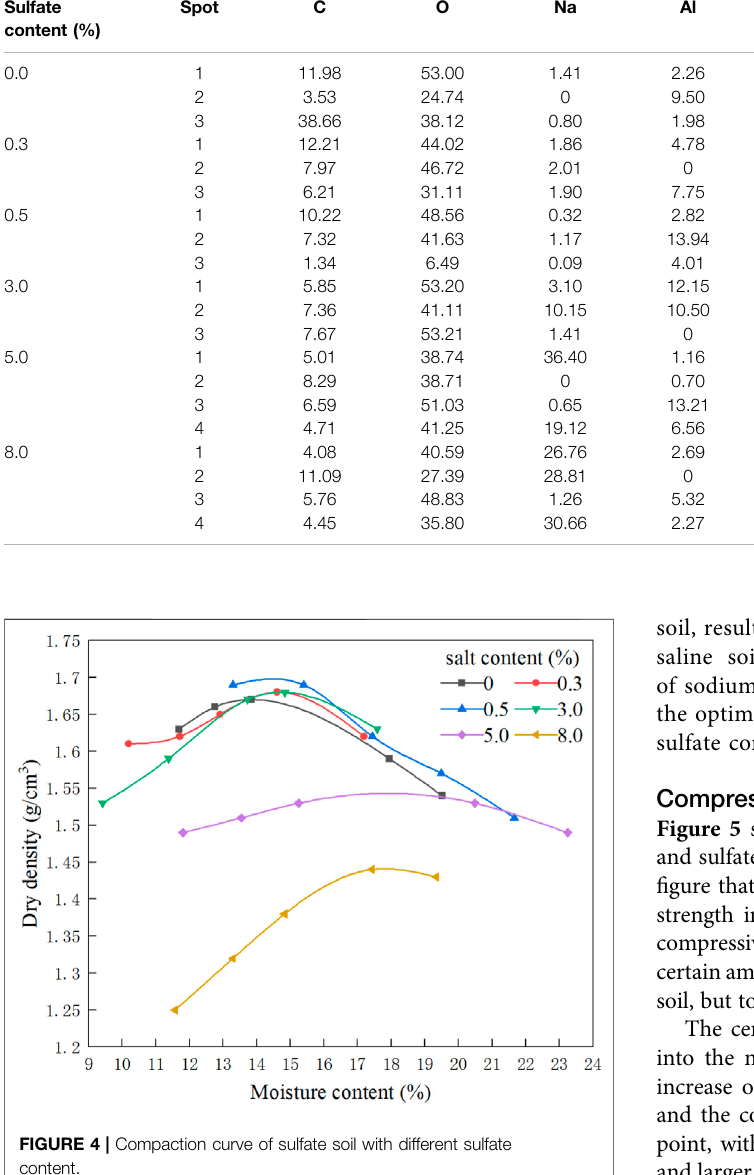
TABLE 7 | Element weight percentage statistics of different sulfate content in saline soil. Sulfate content (%)